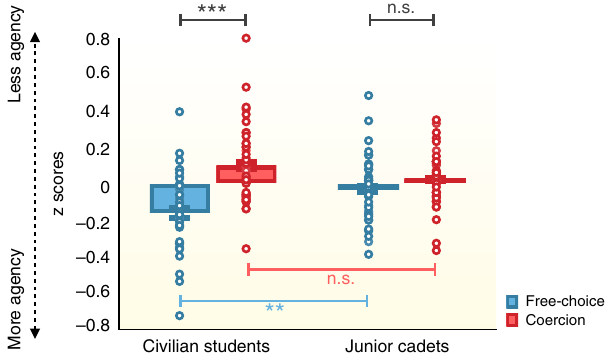
Fig. 1 z -scored interval estimates, used as an implicit measure of sense of agency, in free-choice (blue) and coercion (red) conditions for both junior cadets ( n = 38) and student civilians ( n = 39). Graphical display showing the interaction Condition*Group in a mixed ANOVA with independent (red, blue signi fi cance lines) and paired (black signi fi cance lines) sample t -tests. All tests were two-tailed. Data are presented as mean values ± SEM. Errors bars represent standard errors. *** represents a p -value ≤ 0.001. ** represents a p- value between 0.001 and 0.01. n.s. indicates a non-signi fi cant result. z -scores were higher for the group of junior cadets than for the group of civilian students in the free-choice condition ( p = 0.005). Colored dots represent individual participant data. Source data are provided as a Source Data fi inter-subject variability by subtracting from each interval estimate